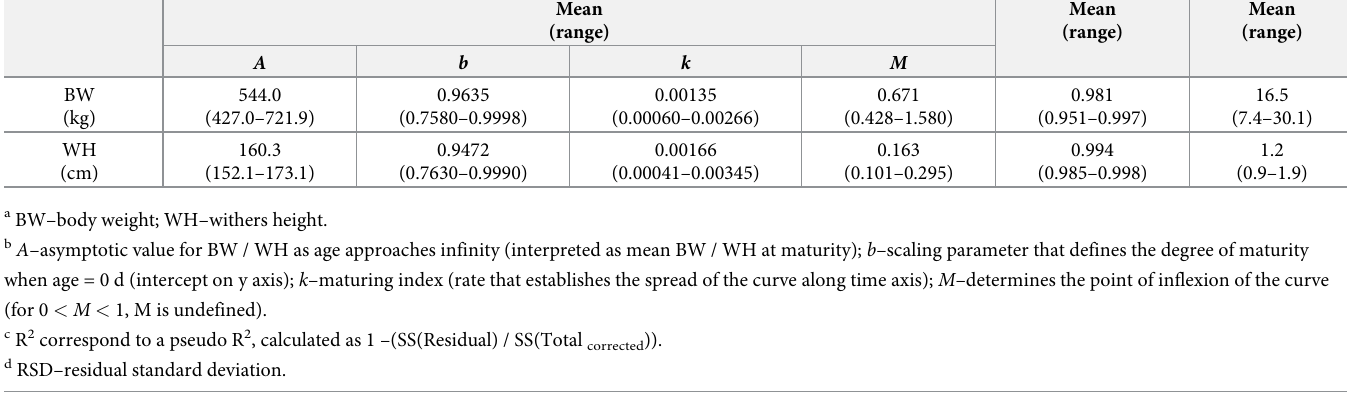
Table 1. Descriptive statistic of the parameter estimates of the individual growth models fitted to body weight and withers height of Lusitano horses (n = 34). Measure a